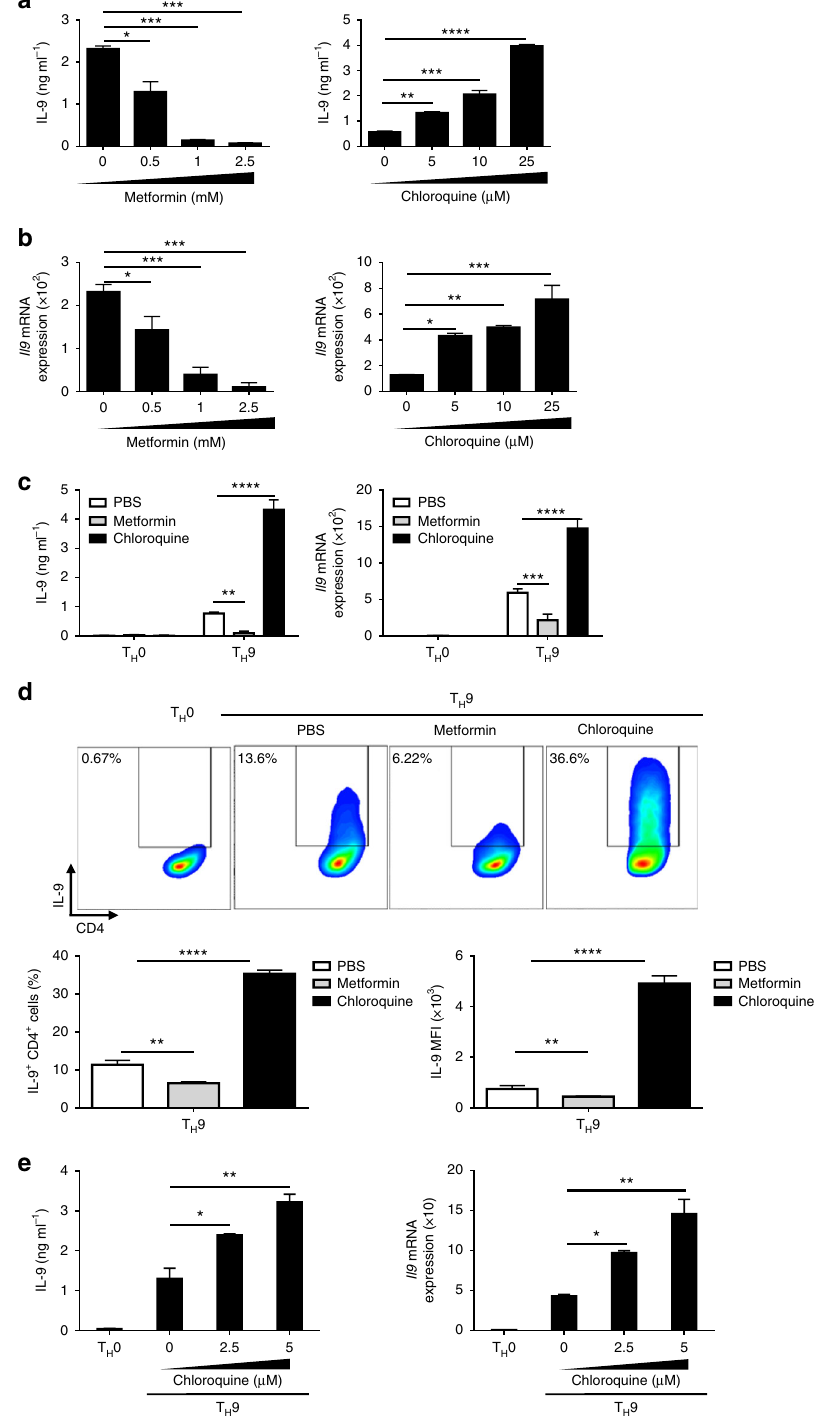
Fig. 3 Mouse and human T H 9 cell differentiation can be pharmacologically altered through modulation of autophagy. a , b Wild-type mouse naive CD4 + T cells were differentiated into T H 9 cells with increasing doses of metformin or chloroquine and then IL-9 secretion levels were determined by ELISA and qRT-PCR after a 3-day culture. qRT-PCR results were normalized to the expression of Actb . Data are representative of three experiments. Naive CD4 + T cells were isolated from IL-9-EGFP mice and differentiated into T H 9 cells for 3 days in the presence of metformin (1mM) or chloroquine (25 μ M) and IL-9 expression was analysed by c ELISA, qRT-PCR and d fl ow cytometry. FACS plots are representative of three experiments. The frequencies and mean fl uorescence intensity (MFI) of IL-9-expressing cells are depicted ( right panels ). e Naive human CD4 + T cells were cell-sorted from three healthy blood donors and differentiated into T H 9 cells in the presence of increasing doses of chloroquine. IL-9 expression was then analysed by ELISA and qRT-PCR, and results were normalized to the expression of Actb and are presented relative to control T H 0 cells. One representative experiment with one donor is shown. Data are representative of three experiments. Mean (+s.d.), NS, not signi fi cant with P > 0.05; * P < 0.05; ** P < 0.01; *** P < 0.001; **** P < 0.0001 two- way analysis of variance (ANOVA)